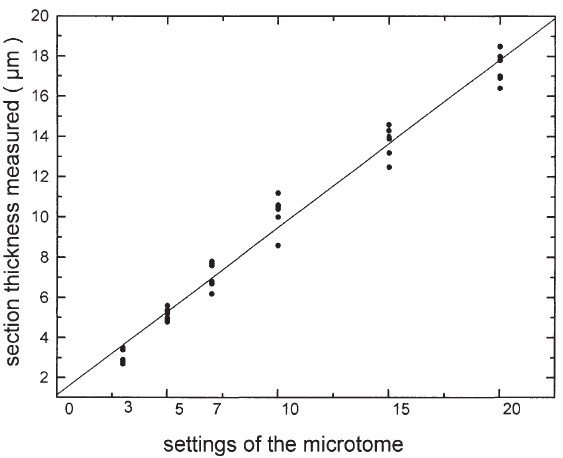
Fig. 3. Linear relationship between the settings of the microtome and the actual thickness of sections of a PAS stained